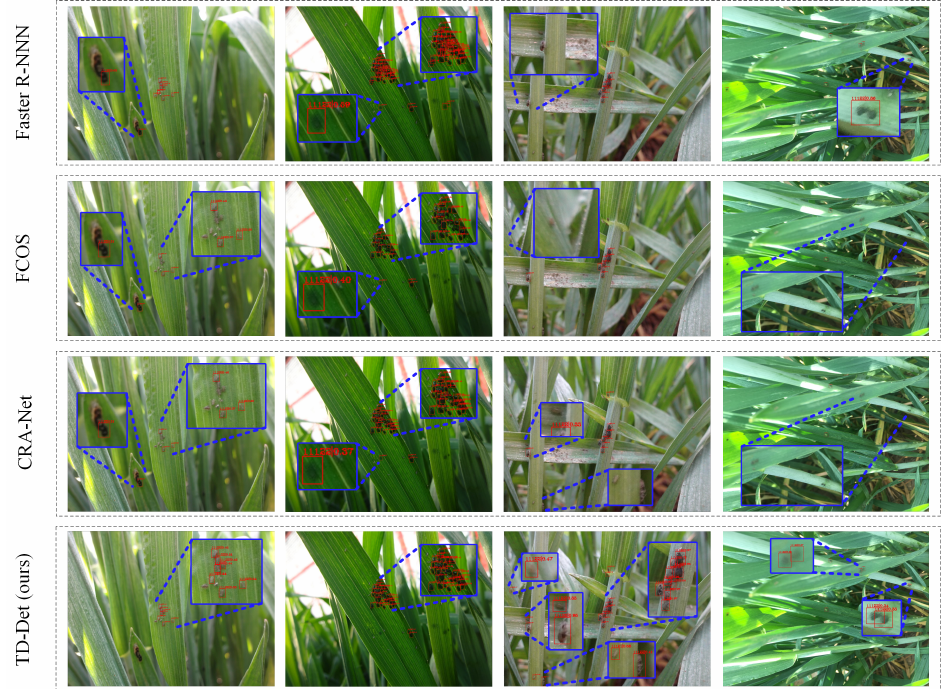
Figure 6. Comparison and visualization of detection results with other